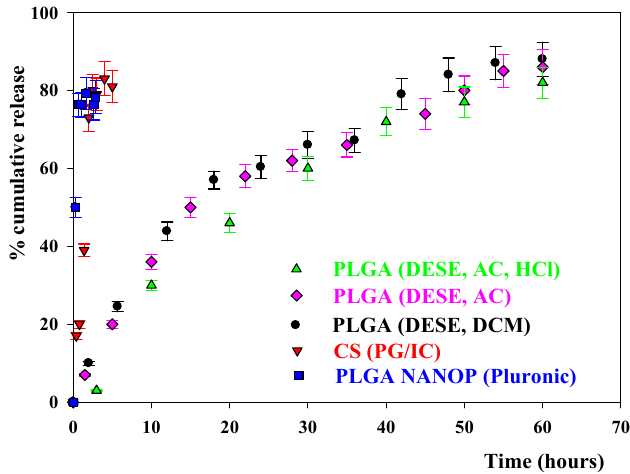
Figure 2. The cumulative release from PLGA and CS nanoparticles prepared by different